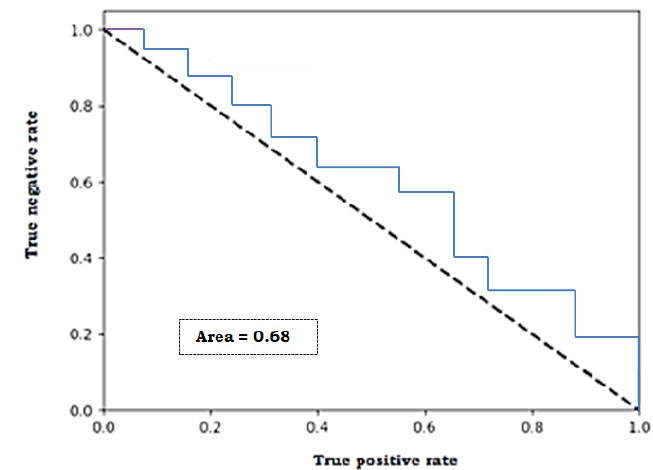
Figure 6. Receiver operating characteristic curve for multilayer perceptron.